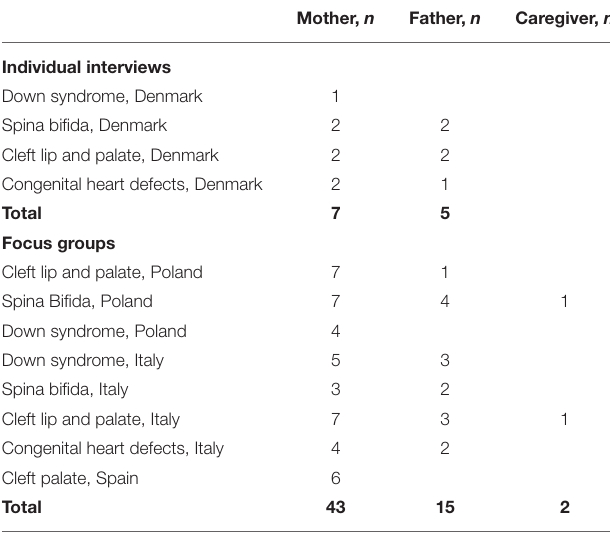
TABLE 1 | Participants in interviews and focus